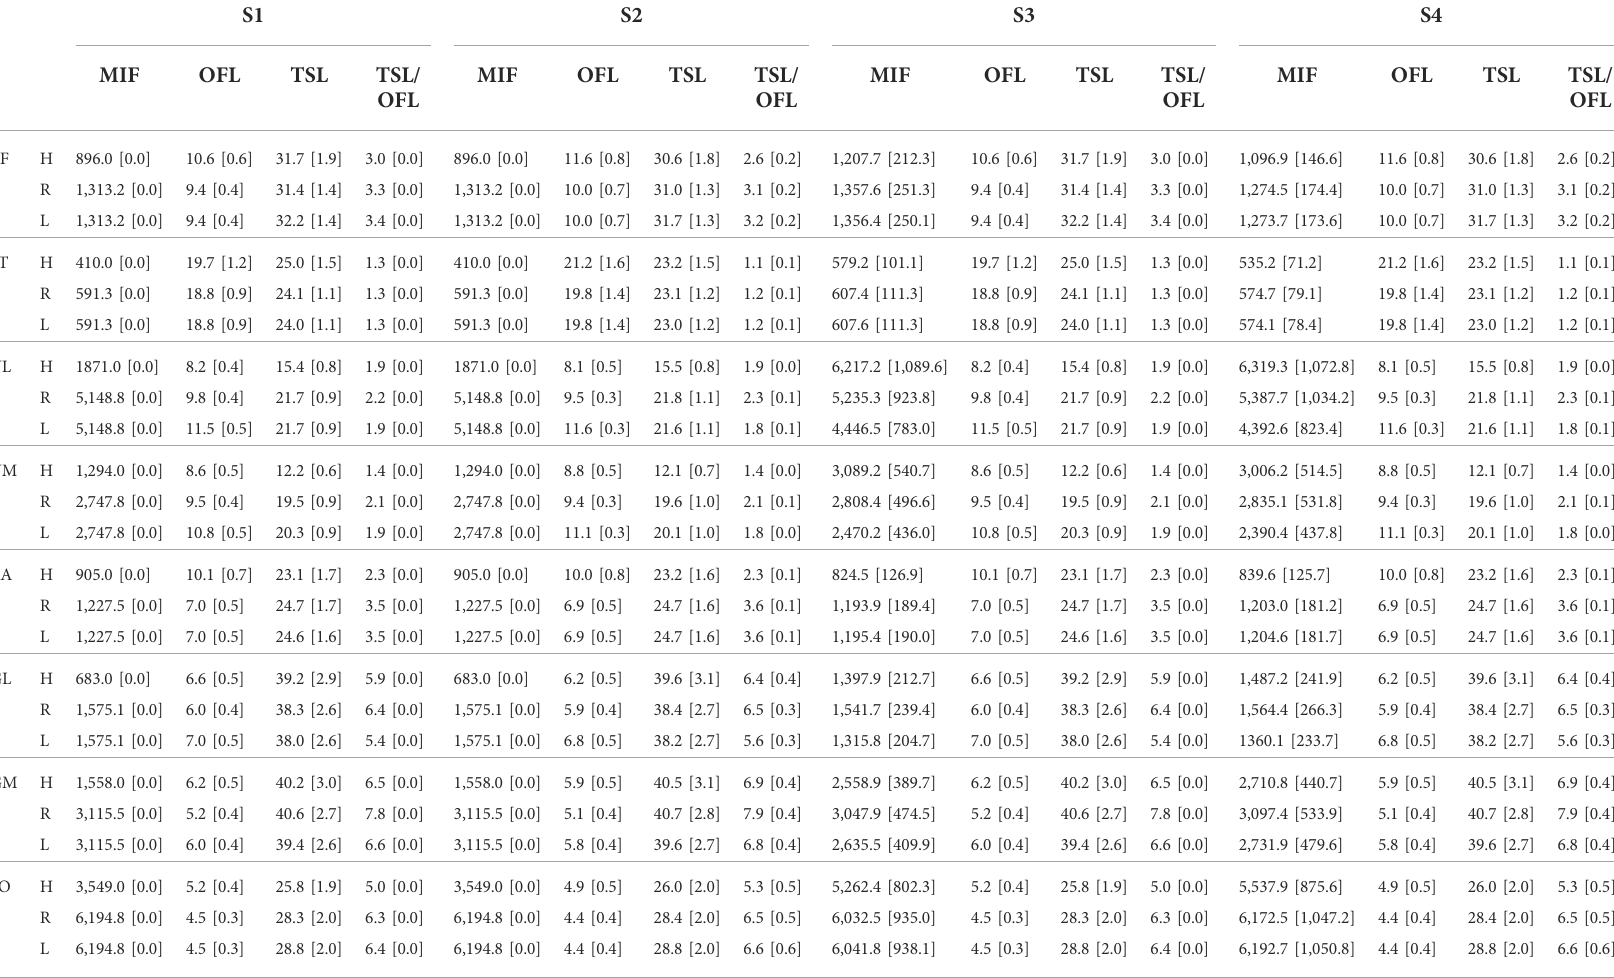
TABLE1AverageandSDofMIF[N],OFL[cm],TSL [cm],andMTUcompliance, de fi ned asTSL/OFL, amongall subjects scalingvariants:linear scaling ofOFLandTSLandgeneric MIF(S1),non-linearscaling ofOFLandTSLandgenericMIF(S2),linearscalingofOFLandTSLandscaledMIF(S3),andnon-linearscalingofOFLandTSLandscaledMIF(S4),inHamner(H),Rajagopal(R),andLai-Arnold(L)models in 8